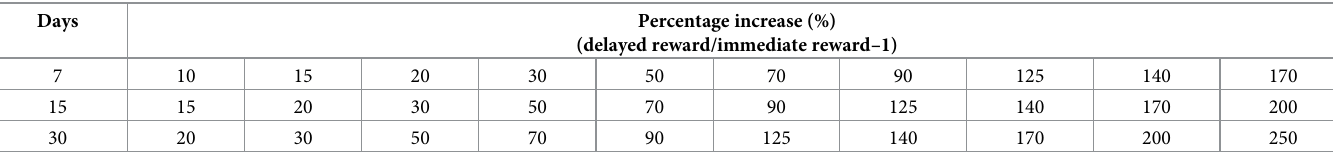
Table 2. Percentage of increasing in delayed rewards compared with immediate